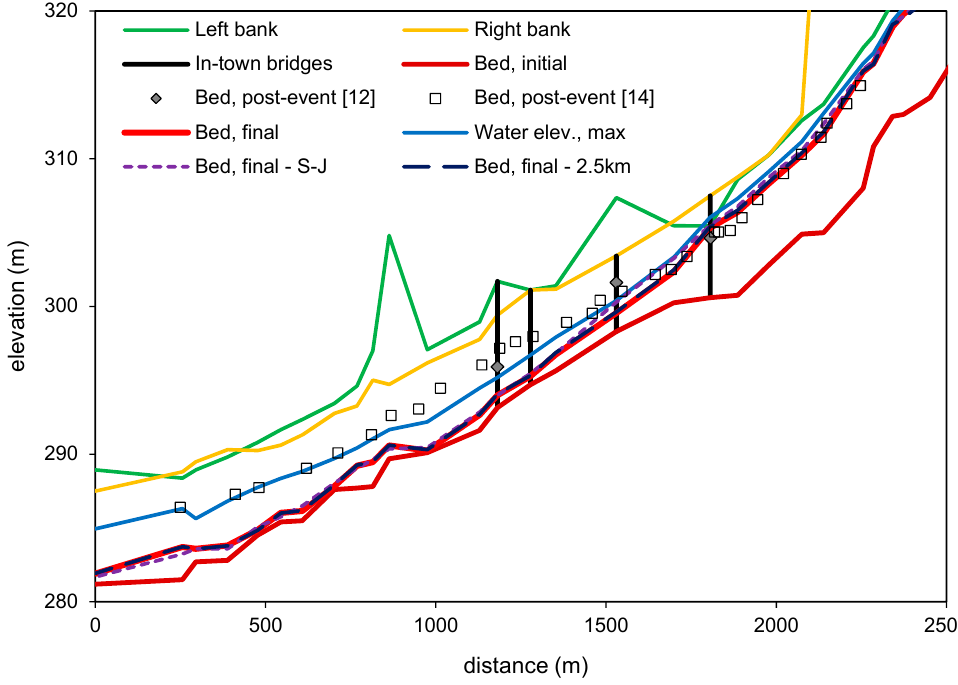
Figure 12. Comparison between the numerical simulation of the 1987 flood event and field data for the bed elevation at the end of the event, including sensitivity analyses for the transport formula (S-J = equation by [36]) and for the location of a transition in sediment size (moved from 1.8 to 2.5 km).